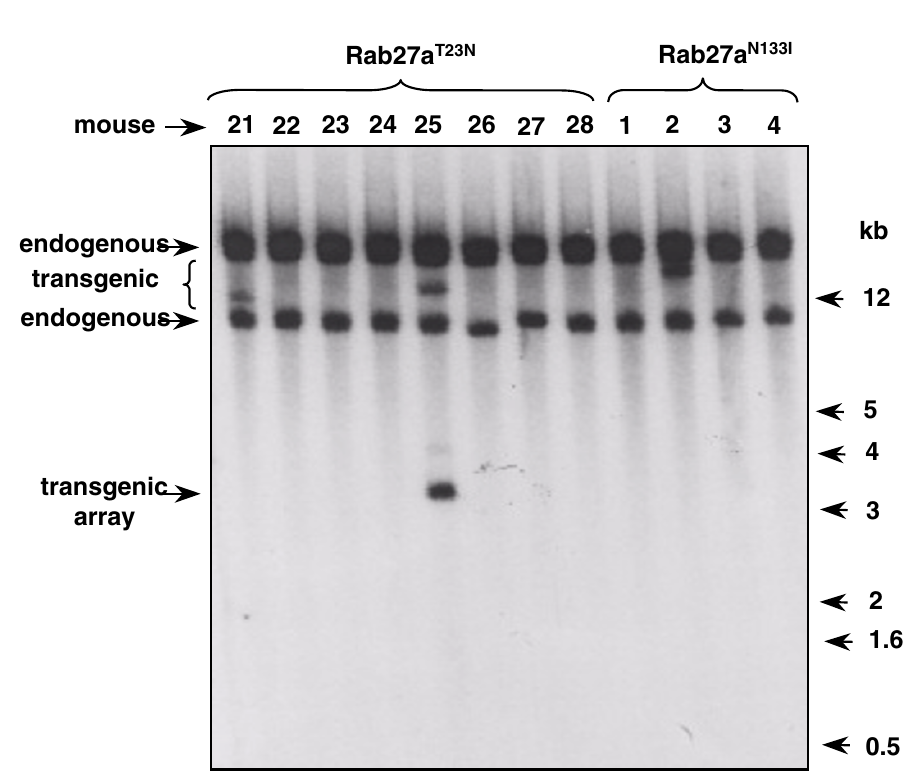
Figure 2 Screening of transgenic mice. Southern analysis was performed using mouse genomic DNA extracted from the tail of potential Rab27a T23N and Rab27a N133I transgenics. Each well contains genomic DNA extracted from an individual mouse tail biopsy and electrophoresed on an agarose gel as described under "Methods". The band around 3.4 kb suggests the presence of an array of